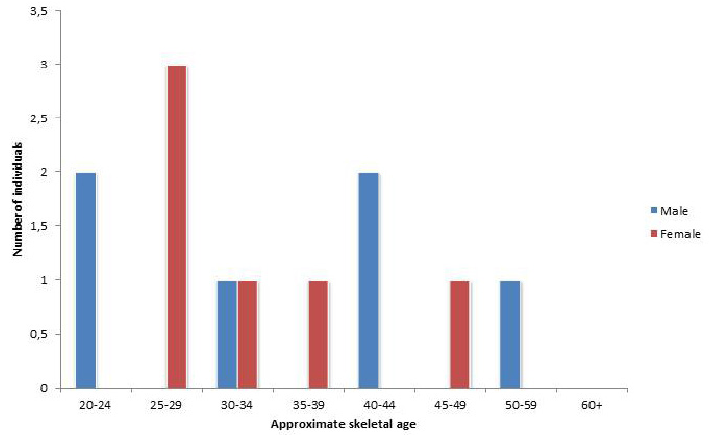
Figure 4. Age-at-death distribution based on tooth eruption using Schour and Massler (1941), available in Hillson (1996, p. 143), and on dental wear (Miles, 1962).